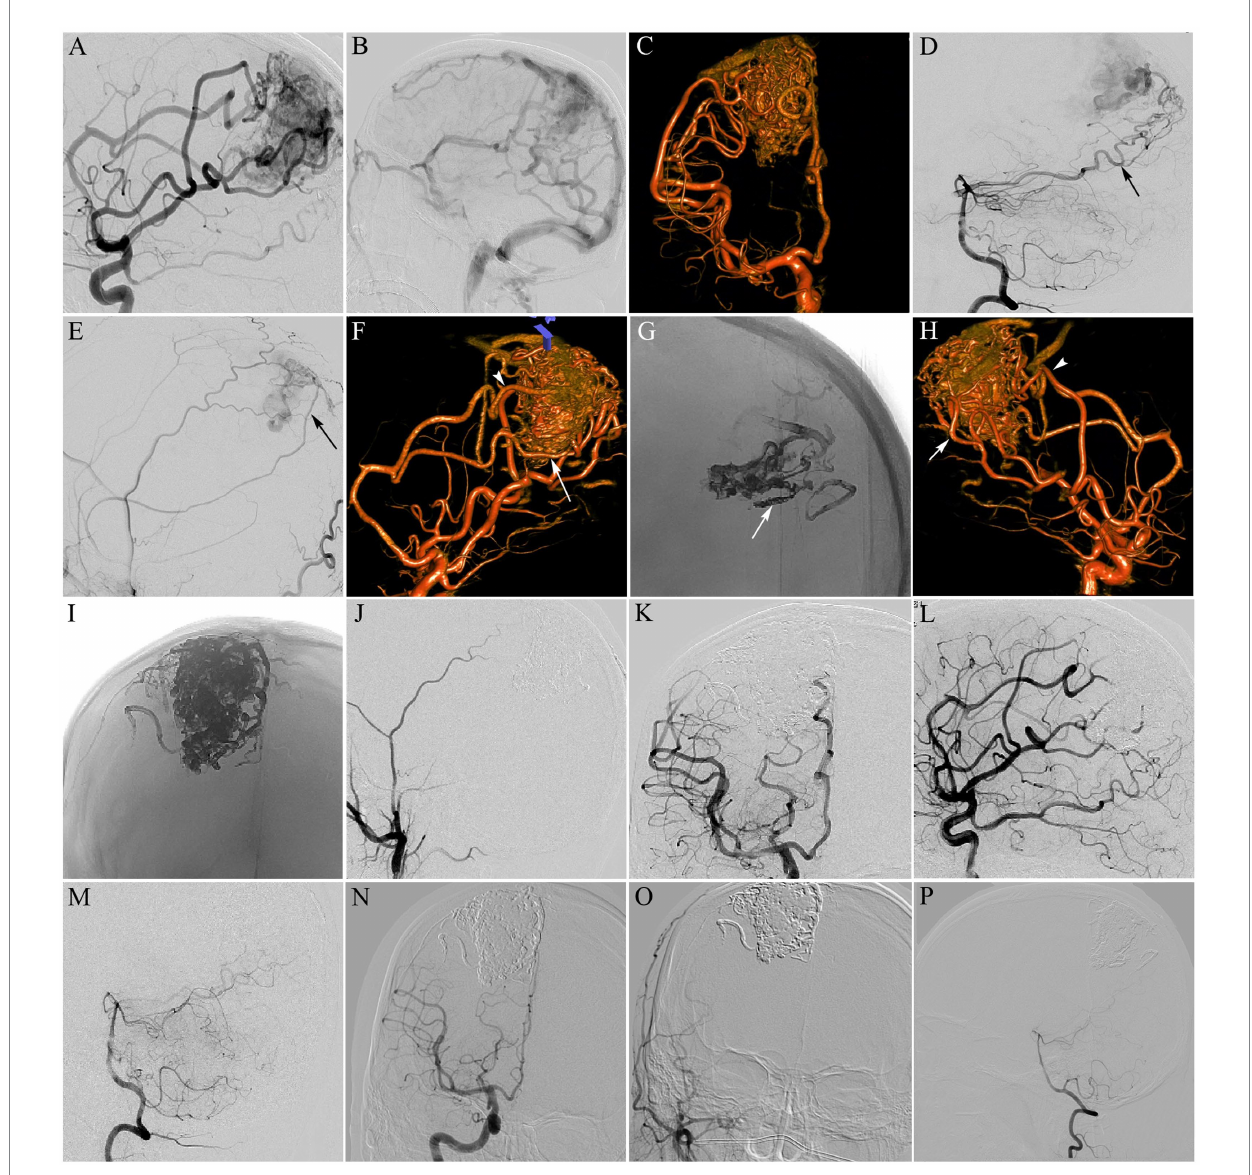
FIGURE 2 Parietal AVM, Spetzler-Matin grade III. The patient had seizure symptoms. (A,B) Selective right internal carotid artery (ICA) injection (lateral views) DSA revealing a 5-cm AVM nidus, supplied by branches from the right anterior (ACA) and middle (MCA) cerebral arteries, and drained by cortical venous to the superior sagittal sinus (SSS); (C) Three-dimensional rotational angiography from the right ICA better delineated the angioarchitecture of the AVM; (D,E) Selective right vertebral artery (VA) injection [lateral (D) view] and selective right external carotid artery (ECA) injection [lateral (E) view] DSA showing the nidus, also supplied by the right posterior cerebral artery (PCA; black arrow in D ) and the right middle meningeal artery (MMA; black arrow in E ); (F) Three-dimensional rotational angiography better delineated enlarged pericallosal artery (white arrow) and enlarged callosomarginal artery (white arrowhead) feeding the nidus. The pericallosal artery was selected for Onyx embolization by the pressure cooker technique; (G) A plug of coils and glue was generated to avoid reflux (white arrow). Single-shot DSA revealing Onyx cast after completing the first pressure cooker embolization; (H) Three-dimensional rotational angiography showing the nidus, also fed by the superior (white arrowhead) and inferior (white arrow) trunks of the MCA. The inferior trunk of the MCA was selected for the second embolization by the pressure cooker technique; (I) Single-shot DSA revealing Onyx cast after completing the second pressure cooker embolization; (J) The last embolization was performed through the MMA to occlude the residual nidus. DS angiogram of the right ECA after embolization revealing total obliteration of residual bAVM; (K–M) Selective right ICA and left VA injection DSA obtained immediately postoperatively showing complete nidus exclusion; (N–P) The 13-month follow-up angiogram confirmed complete bAVM